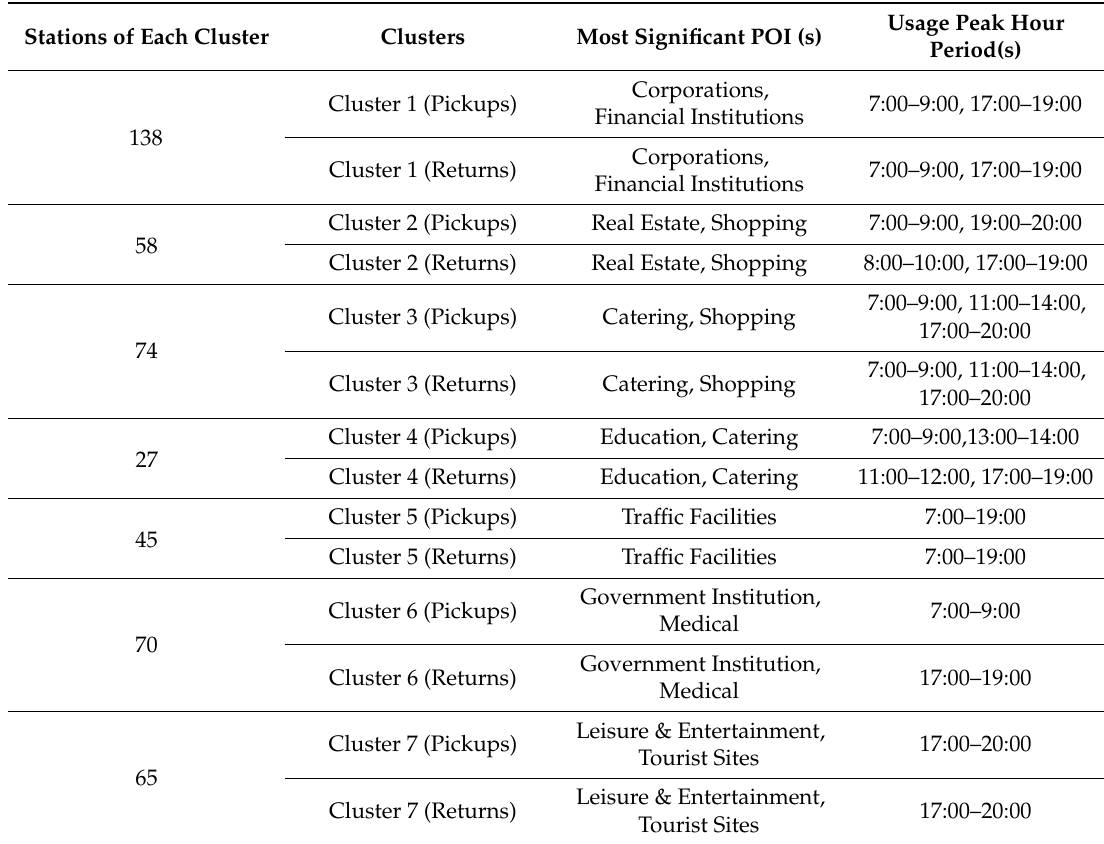
Table 4. Most significant POI (s) and usage peak hour period(s) for each